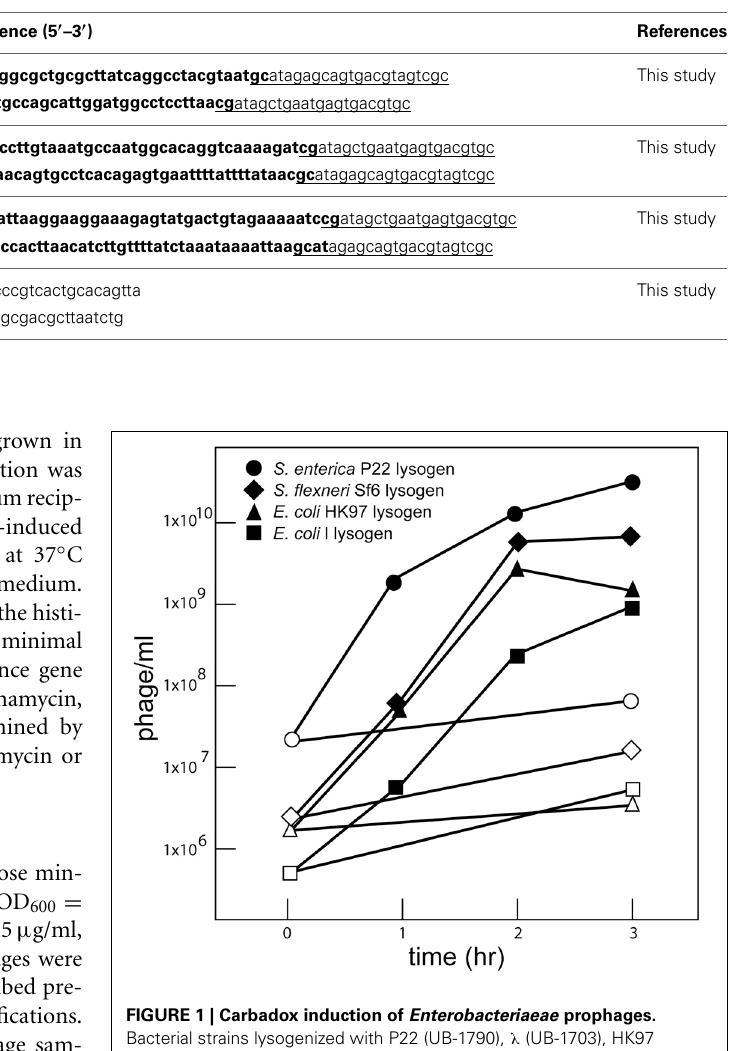
Table 2 | Primers used in this study.